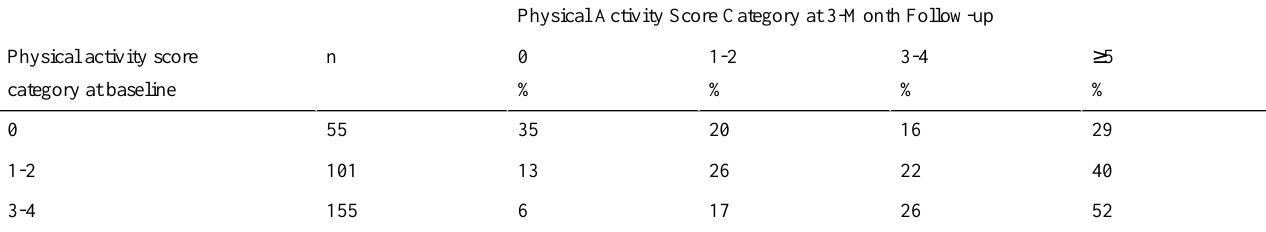
Table 4. Change in physical activity score category from baseline to 3-month follow-up in all responders (n = 311) Physical Activity Score Category at 3-Month